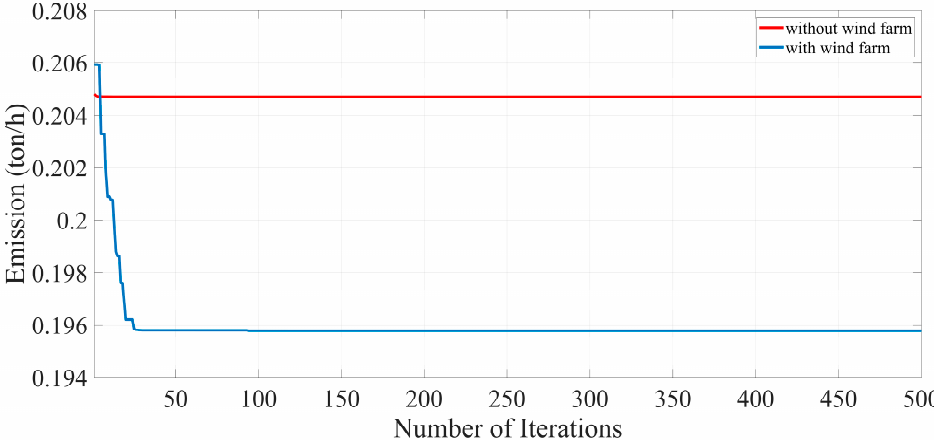
Figure 5. The convergence curves for the minimization of power losses across the transmission lines for the Test System 1.